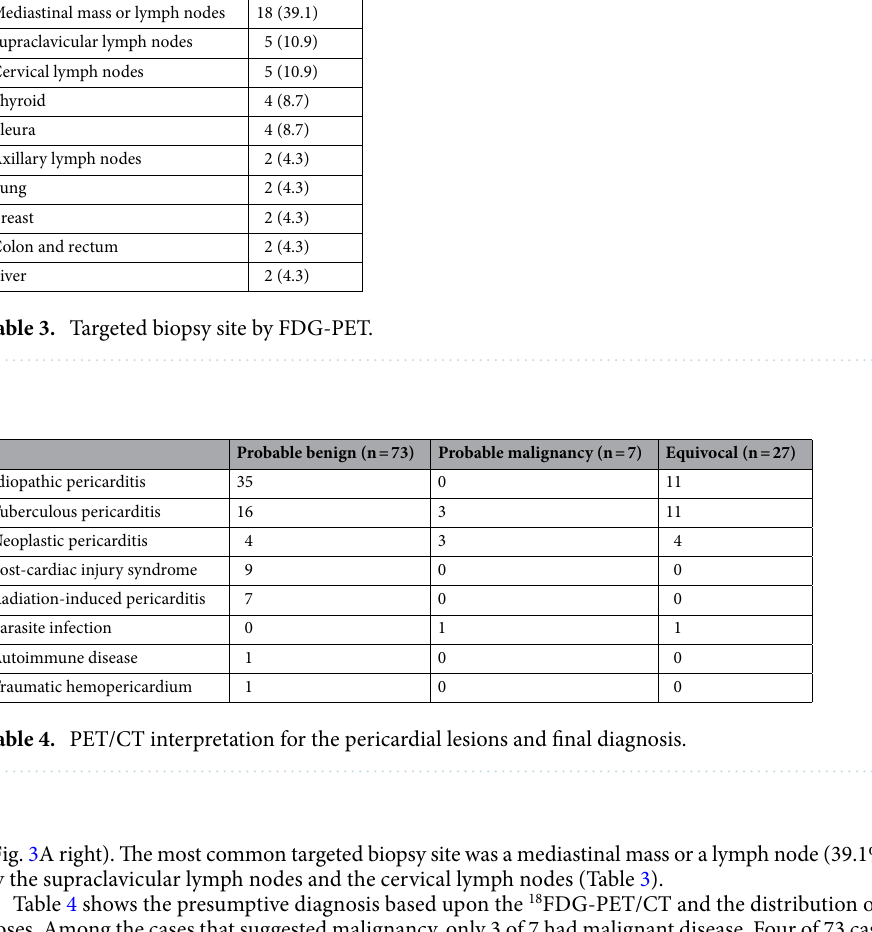
(Fig. 3A right). The most common targeted biopsy site was a mediastinal mass or a lymph node (39.1%), followed by the supraclavicular lymph nodes and the cervical lymph nodes (Table 3). Table 4 shows the presumptive diagnosis based upon the 18 FDG-PET/CT and the distribution of final diag- noses. Among the cases that suggested malignancy, only 3 of 7 had malignant disease. Four of 73 cases reported as benign were finally diagnosed as malignancies. On the basis of uptake pattern, the negative predictive value of 18 FDG-PET/CT to exclude malignancy in pericardial disease was more than 94.5% (69/73).